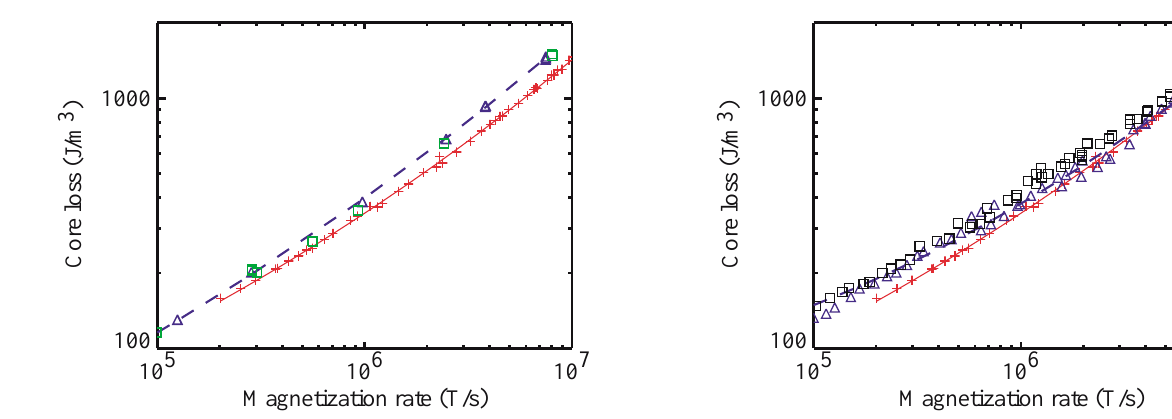
FIG. 8. (Color) Core loss versus magnetization rate for three METGLAS 2605 SC cores, all insulated with cowound mica paper and annealed after winding. The data are for a flux swing of 2.25 T ( (cid:1) , green) C12, ( (cid:3) , blue, dashed line) C13, and ( 1 , red, line) C14.